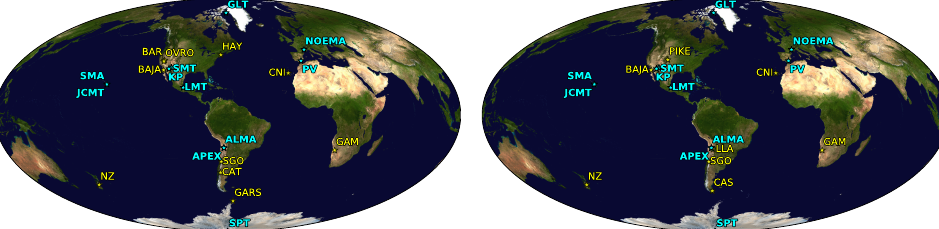
Figure 3. Maps of the two ngEHT array configurations, with the current EHT sites shown in cyan and new ngEHT sites in yellow. The ngEHTa configuration with 6m dishes is shown on the left, and the ngEHTb configuration with 10m dishes is shown on the